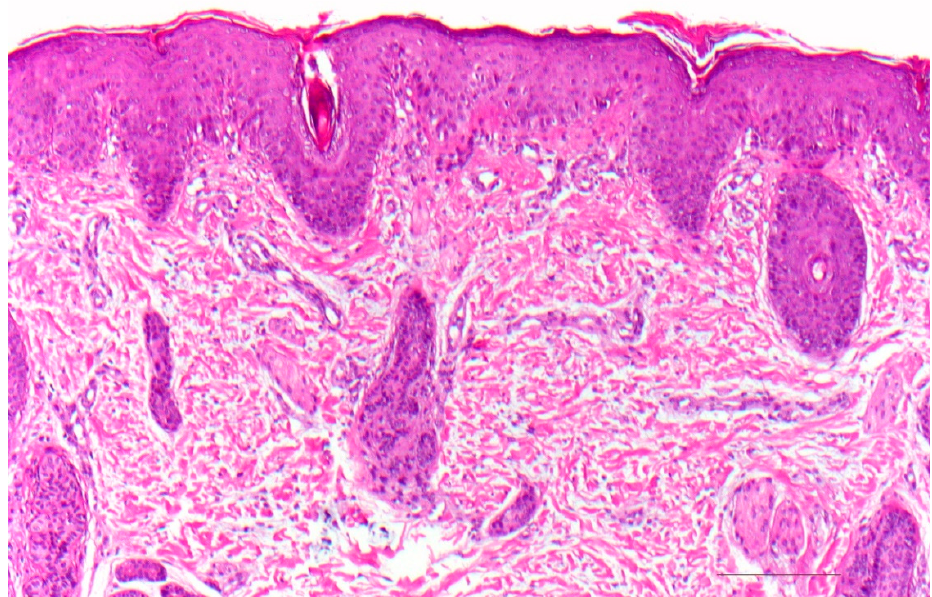
Figure 10. Netherton syndrome. Regular (psoriasiform) hyperplasia with focal parakeratosis and thinned stratum granulosum. Dilated vessels in the papillary dermis and inflammatory infiltrates. HE stain, bar = 100 µm.